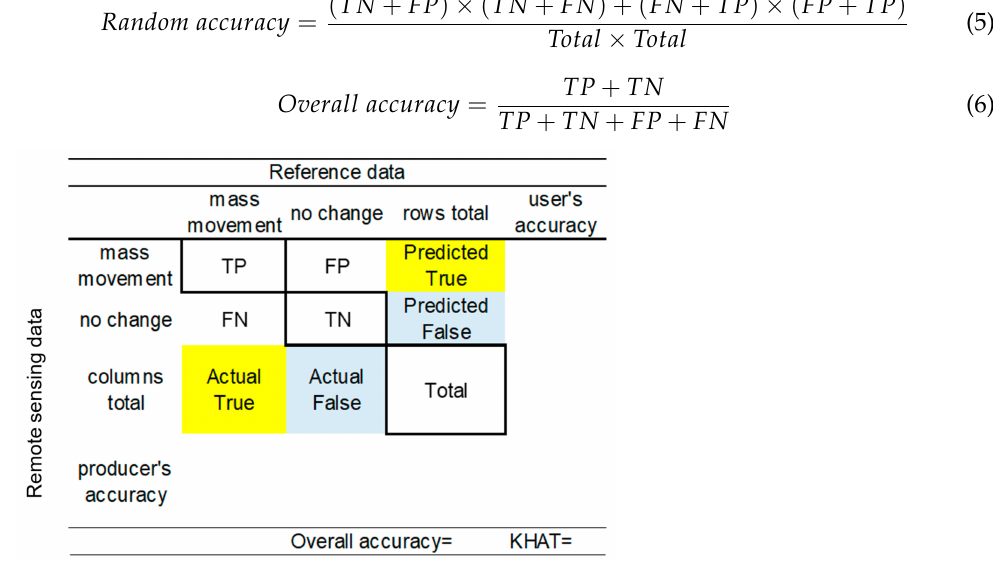
Figure 8. Confusion matrix made of TP (true positives), TN (true negatives), FN (false negatives) and FP (false